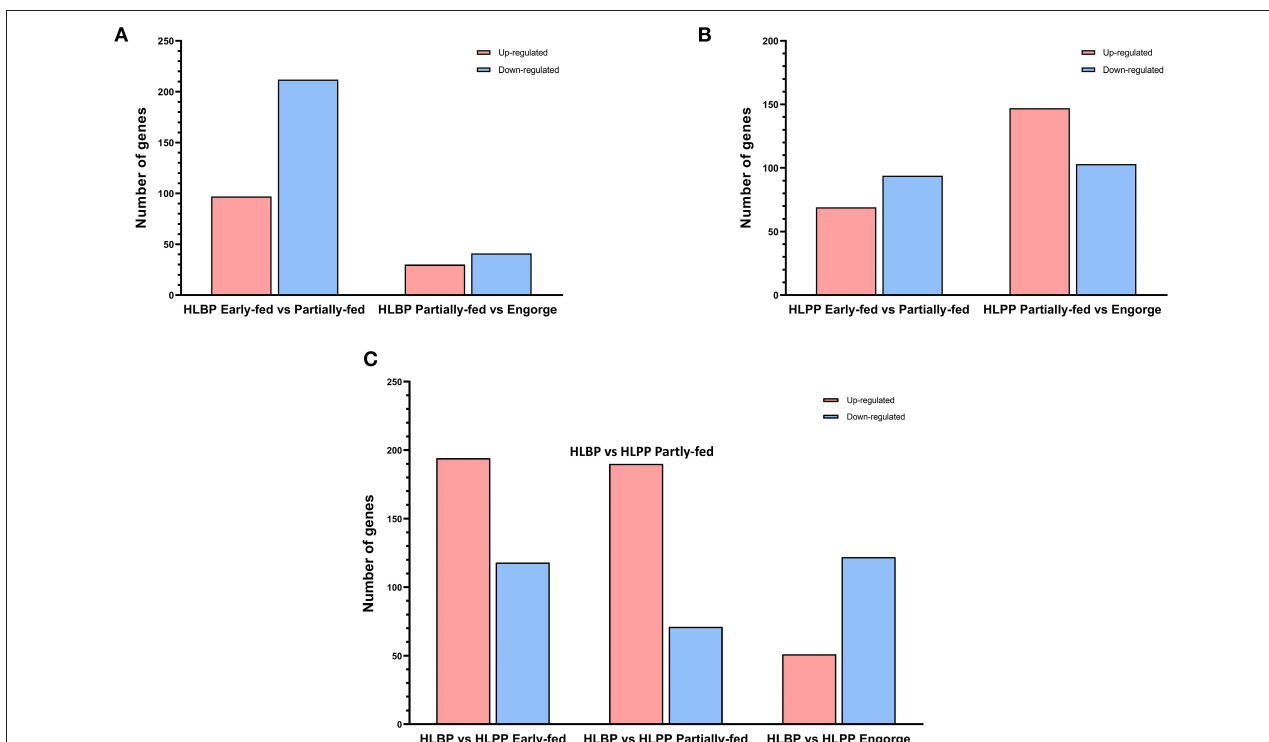
FIGURE 2 | Differentially expressed proteins (DEPs) of H. longicornis ovary. The histogram shows the up-regulated and down-regulated different categories in red and blue, respectively. (A) Comparison of bisexual H. longicornis (HLBP) in different feeding stages. (B) Comparison of parthenogenetic H. longicornis (HLPP) in different feeding stages. (C) Comparison of the different reproductive